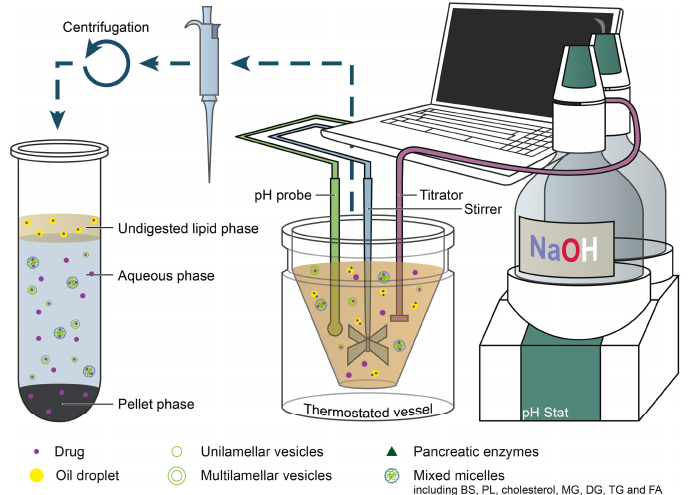
Figure 5. pH-stat lipolysis model for in vitro assessment of lipid-based drug delivery systems.